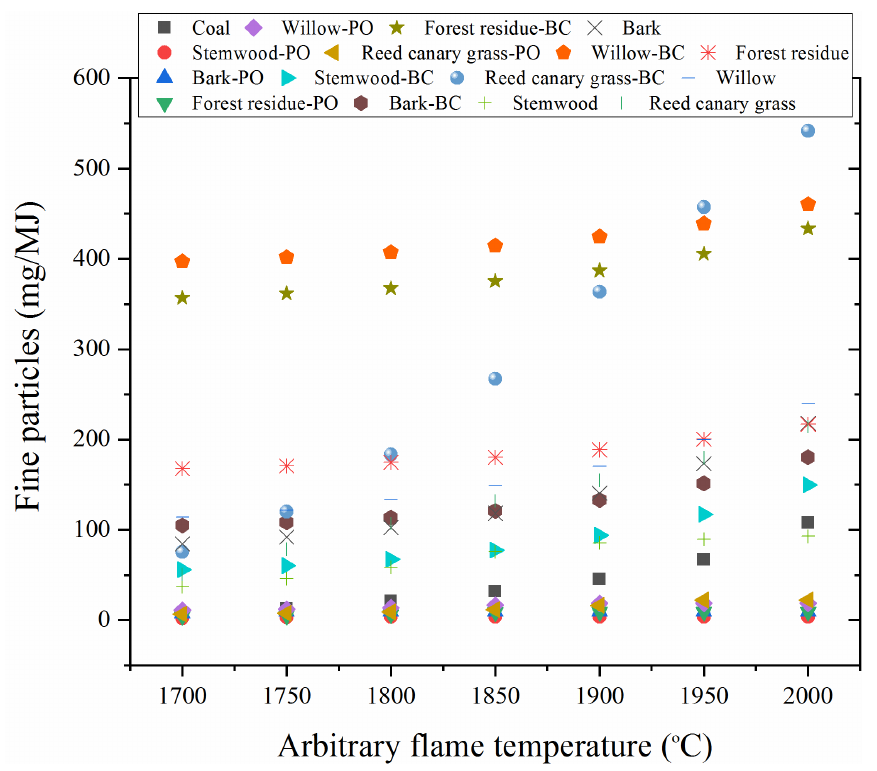
Figure 13. The predicted amount of submicron particles formed through vaporization and recondensation of the vaporized fraction of ash when the temperature drops to 1000 °C at the bottom of the pellet bed .